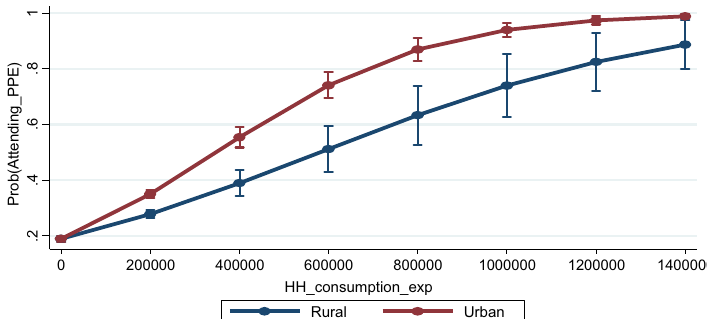
Fig. 3 Predicted probabilities of attending pre-primary education by location and household consumption